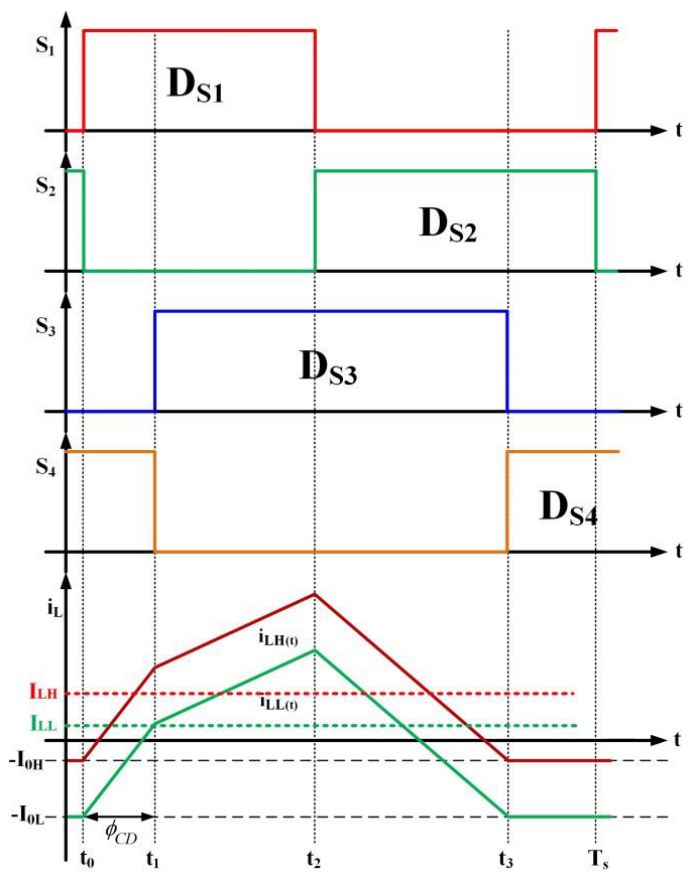
Figure 6. Inductor current waveform under different load conditions (φ fixed).